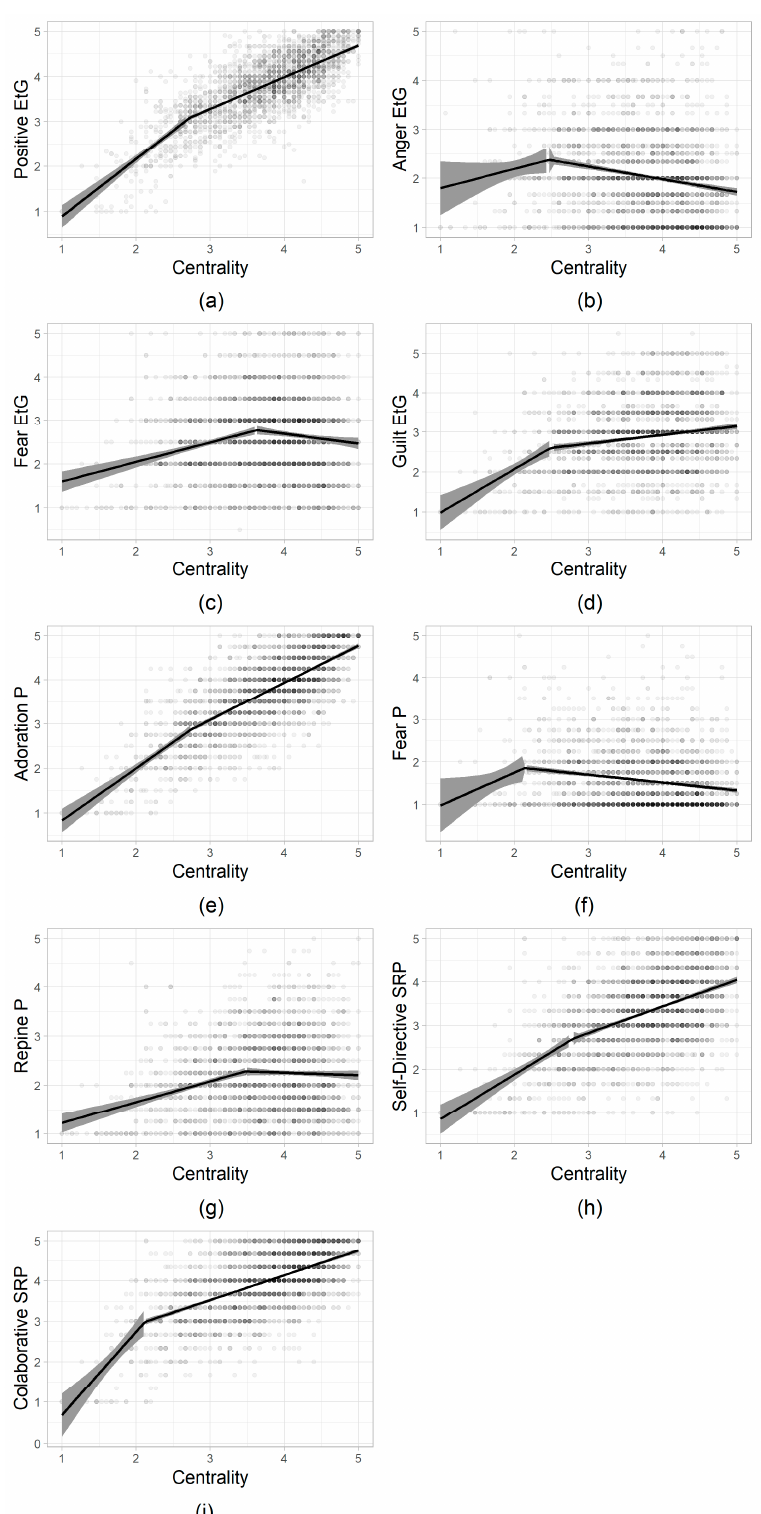
Figure 2. Segmented regression lines for relations between scores of CRS and scores of SRT subscales included in the study ( n = 2331). Black lines are segmented regression lines, gray area is their 95% confidence interval (CI). On panels are regressions on centrality, respectively: ( a ) positive emotions toward God; ( b ) anger toward God; ( c ) fear toward God; ( d ) guilt toward God; ( e ) adoration prayer; ( f ) fear prayer; ( g ) repine prayer; and ( h ) self-directive style.